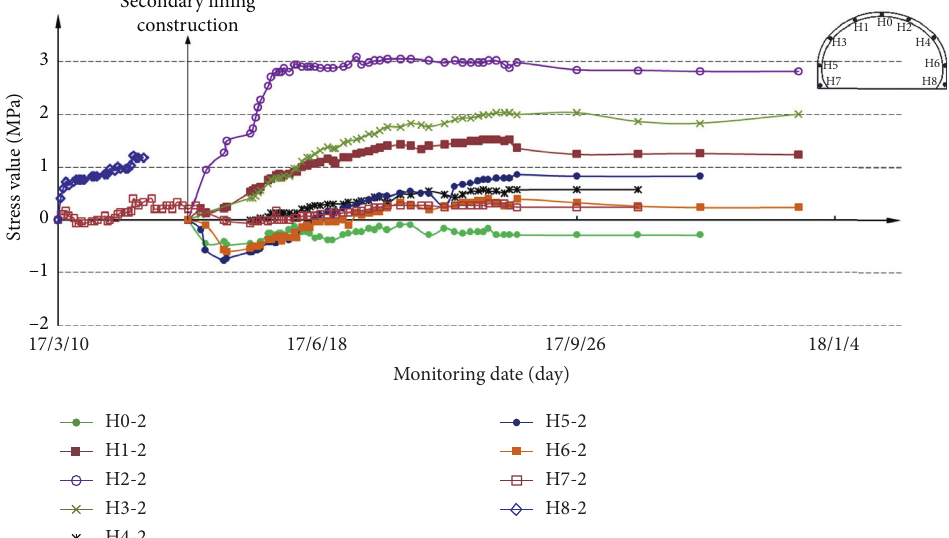
Figure 18: Inner temporal curve of secondary lining concrete at section YK2+449.